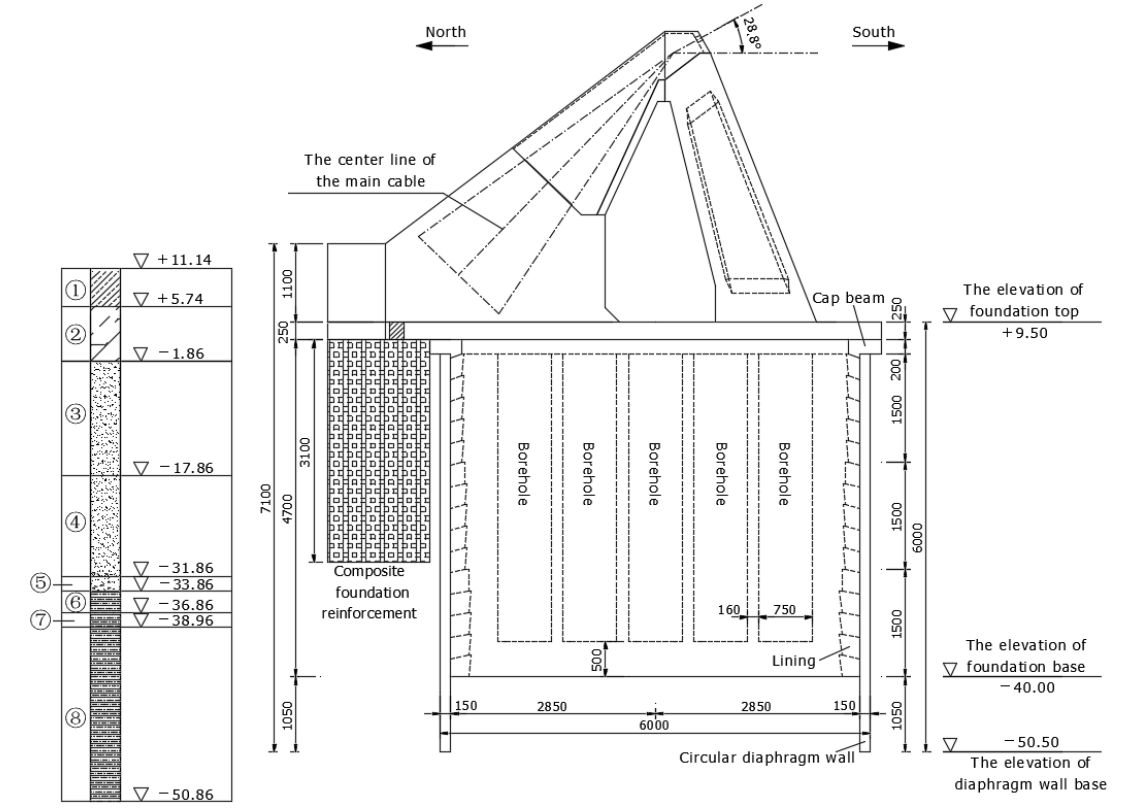
Figure 1. Design size of the north anchorage (the unit of elevation is “m”, and the rest are in “cm”).